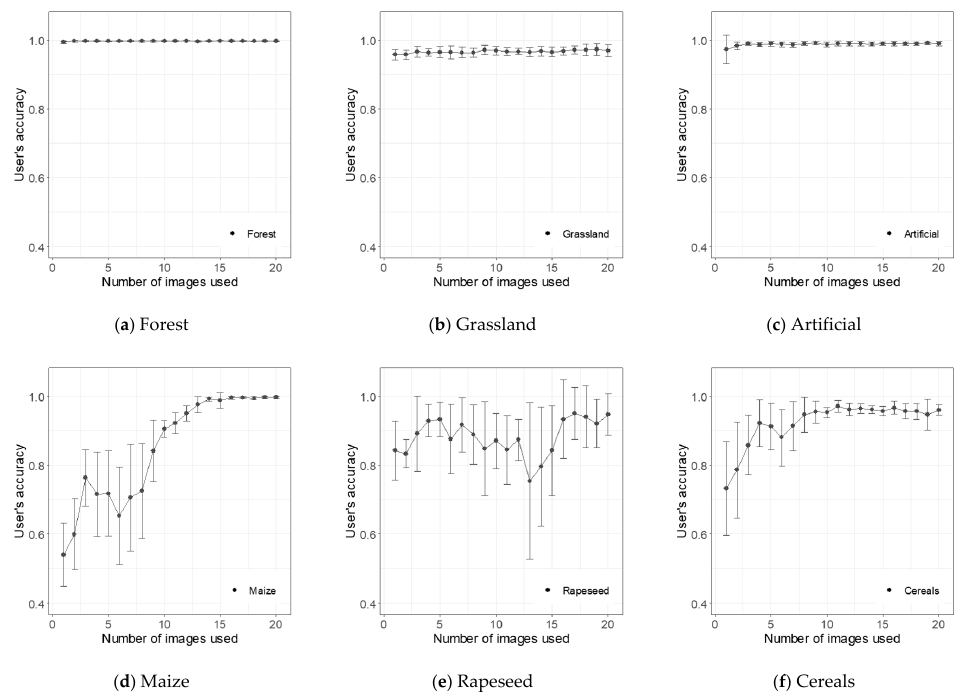
Figure 8. For Study Area 1, the mean UA of classification (repeated at 12 segmentation scales, from scale 40 to 150) and error bars indicate the mean square errors of different segmentation scales. ( a – f ) show forest, grassland, artificial land, maize, rapeseed, and cereals, respectively.